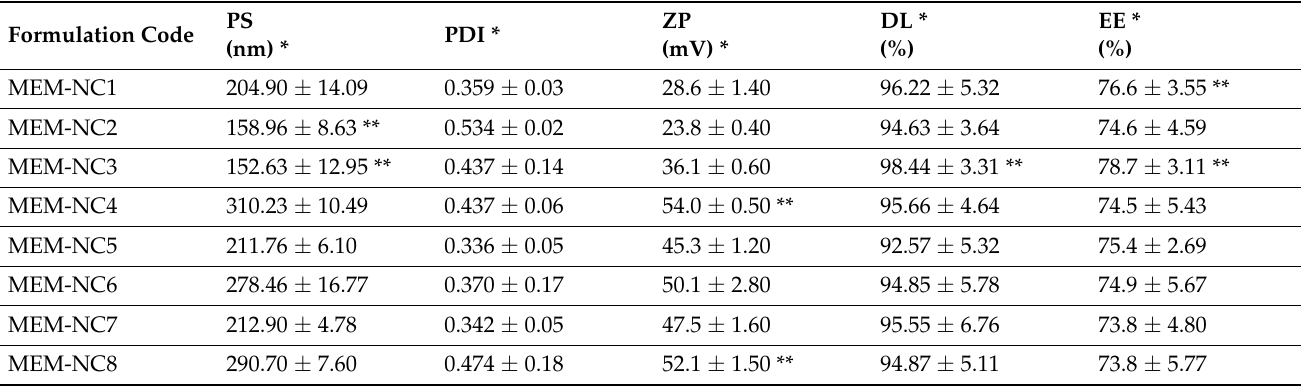
Table 2. Basic physical characteristics of MEM–NCs. * Each value signifies mean ± SD, n = 3; the significant variances compared to control (pure MEM) are denoted by ** p < 0.05, as estimated by the ANOVA test. Otherwise, p >